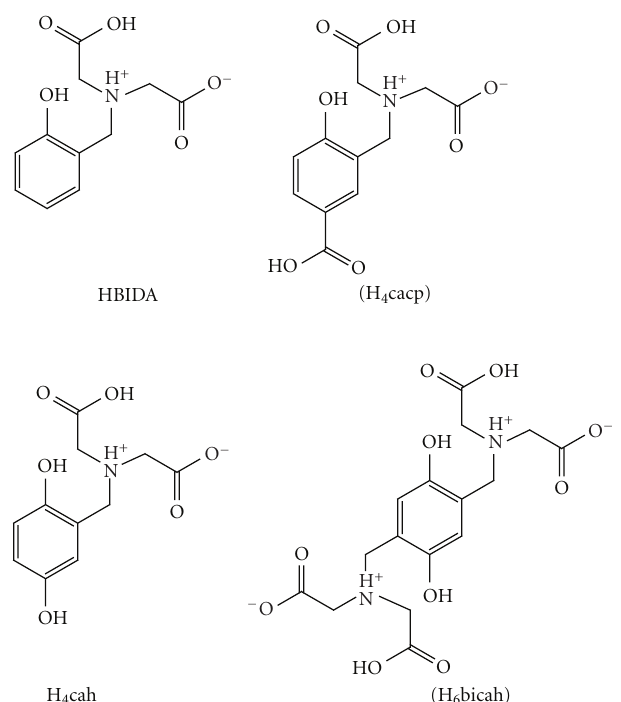
Scheme 1: Iminodiacetic derivatives of phenol/ p -hydroquinone ligands with their abbreviations. The ligands referred to the potentiomet- ric/stability studies are denoted in parentheses.